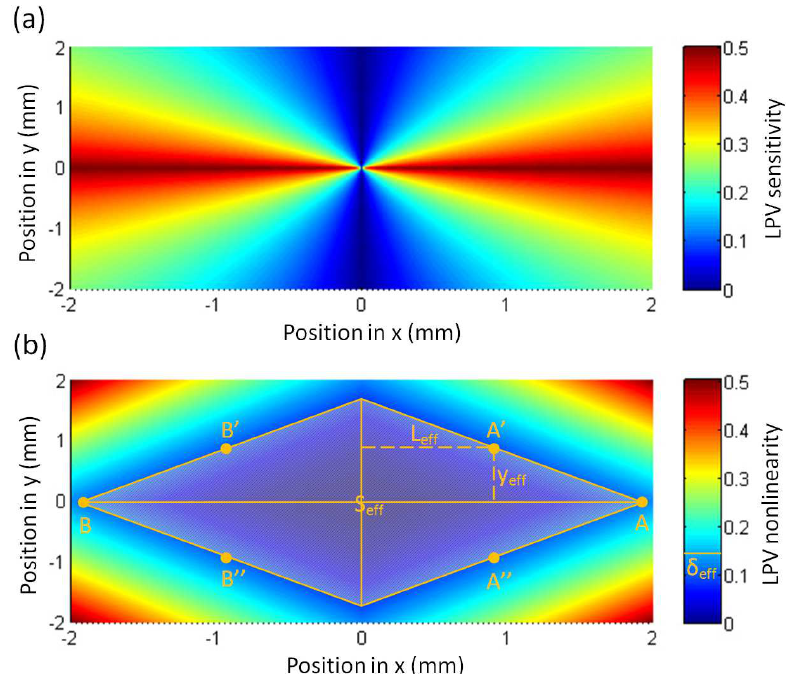
Figure 20. Calculation of normalized (a) LPV sensitivity and (b) nonlinearity vs. both contacts’ distance and vertical offset distance according to Equation (27) and Equation (28), where the parameters are chosen as λ = 2 m